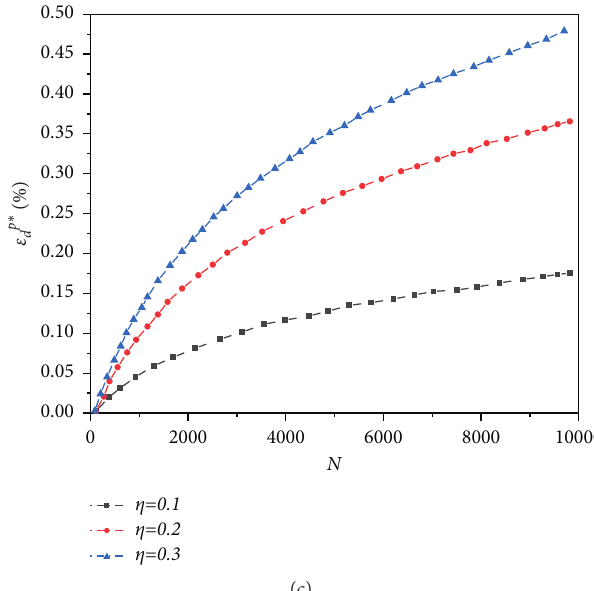
Figure 21: Influence of η on the relationship between cumulative plastic strain and number of vibrations. (a) σ � 120 kPa. and (c) σ 3